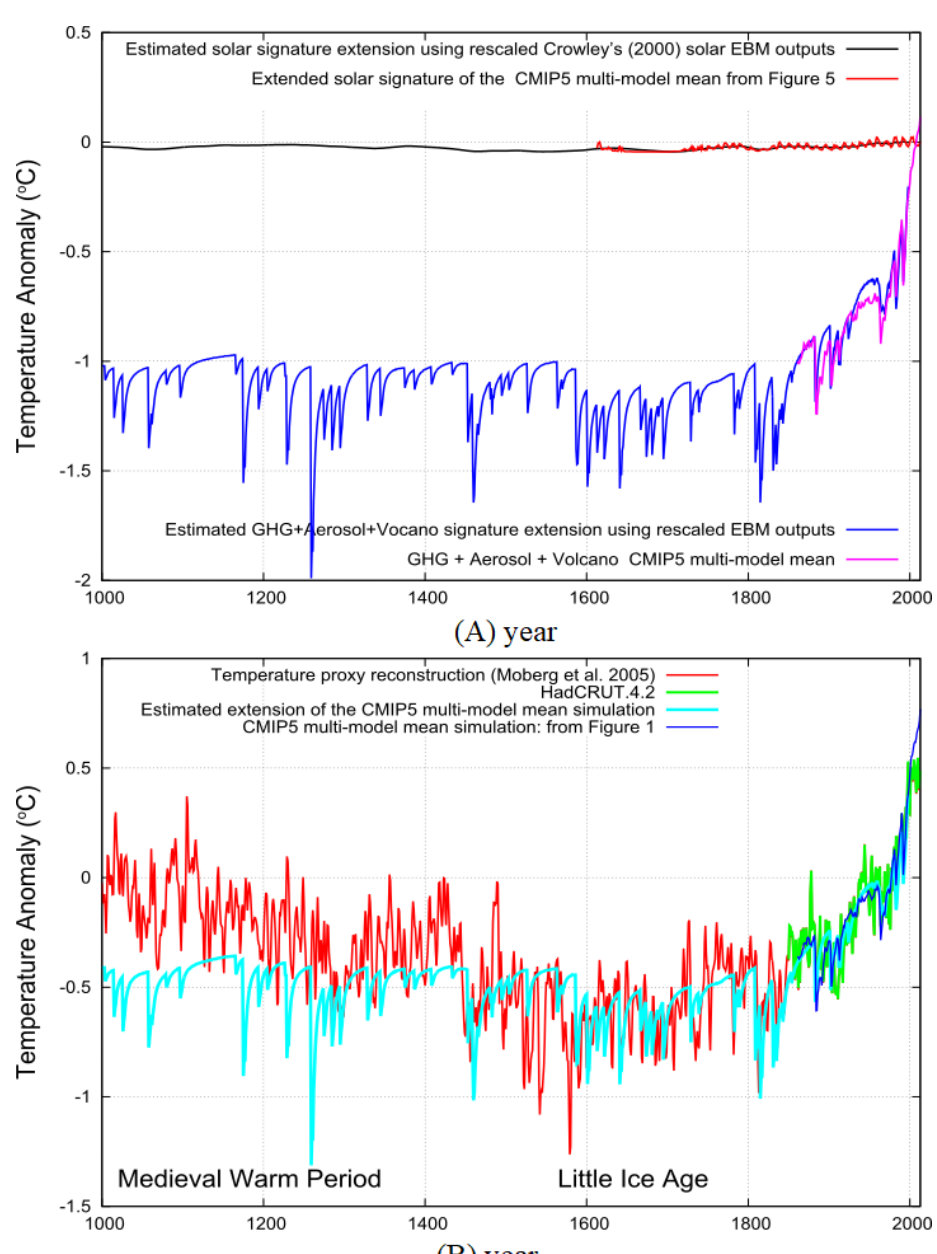
Figure 7. ( A ) Extension of the CMIP5 multi-model mean simulation referring to the solar signa- ture (red and black) and the greenhouse gas (GHG)+Aerosol+Volcano (blue and purple) signature. The extensions are constructed by calibrating the correspondent energy balance model outputs of (Crowley [125], Figure 3)on the CMIP5 multi-model mean estimates. ( B ) Comparison between the extended CMIP5 multi-model mean simulation (cyan) made by summing the black and blue curved in A Equation (5) against the temperature proxy reconstruction by Moberg et al. [124] (red) calibrated and extended with the HadCRUT record (green) since